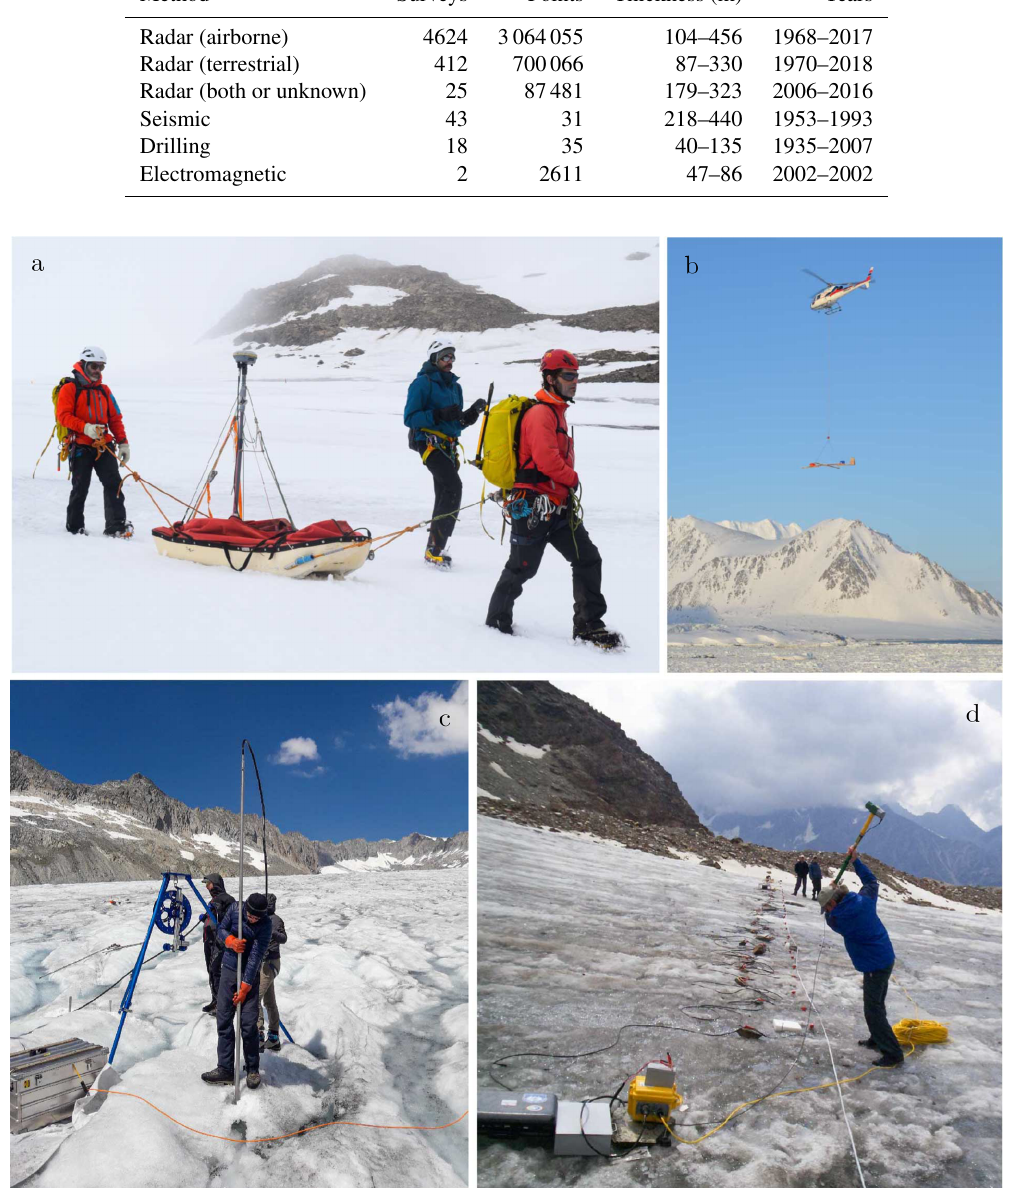
Figure 1. Field photographs illustrating different methods for measuring glacier thickness. (a) Ground-penetrating radar measurements on Johnsons Glacier, Antarctica, in January 2020. The white sledge contains a radar transmitter, receiver, shielded antennas, control unit, and recording system. A Global Navigation Satellite System receiver antenna is mounted to the sledge. Credit: Francisco Navarro. (b) Aerial ground-penetrating radar measurements over Hansbreen, Svalbard, in spring 2011 (Navarro et al., 2014). The radar transmitter, receiver, and antennas are mounted to a wooden frame hung from the helicopter. Credit: Antoine Kies. (c) Hot water drilling on Rhonegletscher, Switzerland, in August 2018 by ETH Zurich’s Glacier Seismology Group. Although used mostly for characterizing bed conditions, the drillings measure ice thickness as a side product. Credit: Johannes Landmann. (d) Seismic reflection measurements on Grubengletscher, Switzerland, using a sledgehammer as a seismic energy source. The black seismic line connects geophones to the recording system. Credit: Bernd